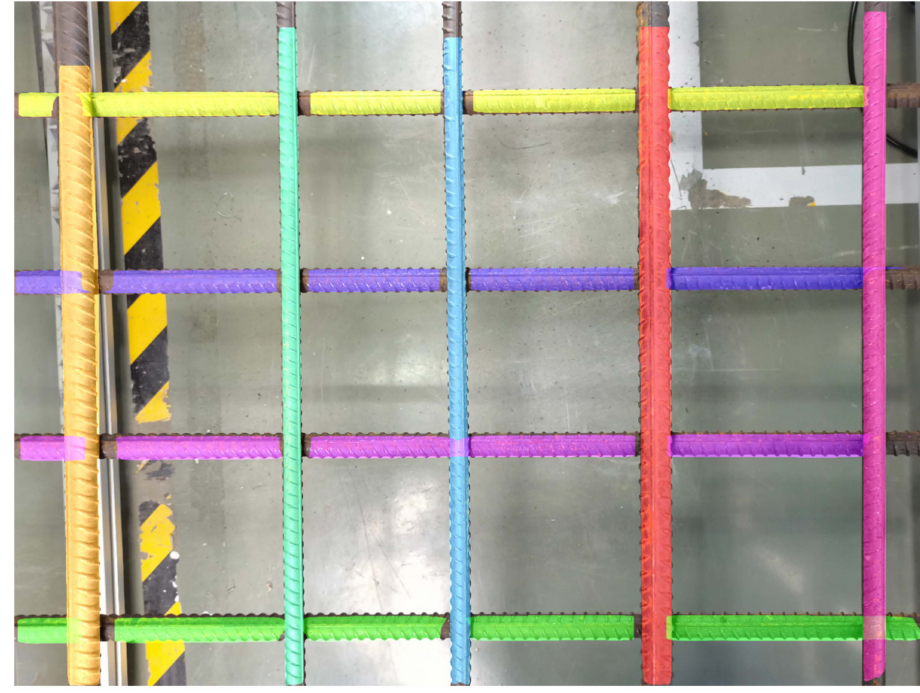
Figure 20. Rebar instance segmentation prediction